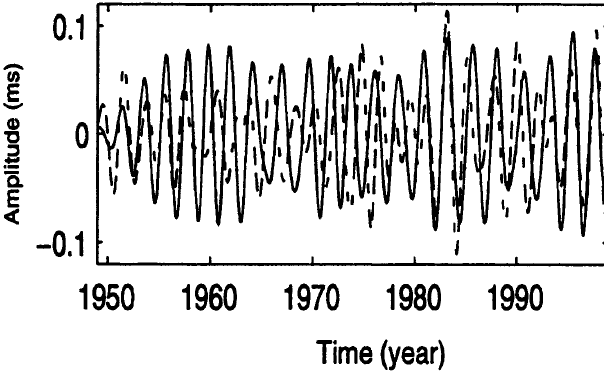
Fig. 9. Interannual variations at the quasi-biennial band (between 1.5 and 2.9 years) of the SAAM ( solid ) and TAAM ( dashed )